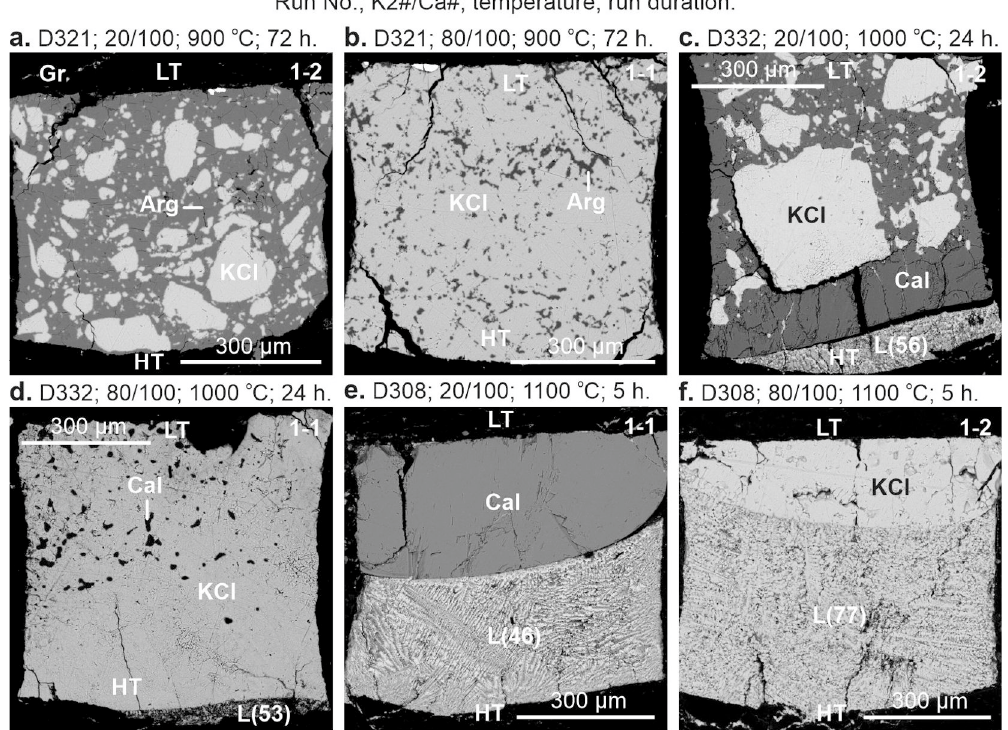
Figure 1. BSE images of sample-cross sections in the system KCl–CaCO 3 at 3 GPa and 900 ( a , b ), 1000 ( c , d ), and 1100 ◦ C ( e , f ). The numbers in parentheses denote the melt K2#. HT—high-temperature side. LT—low-temperature side. The gravity vector is directed downward.